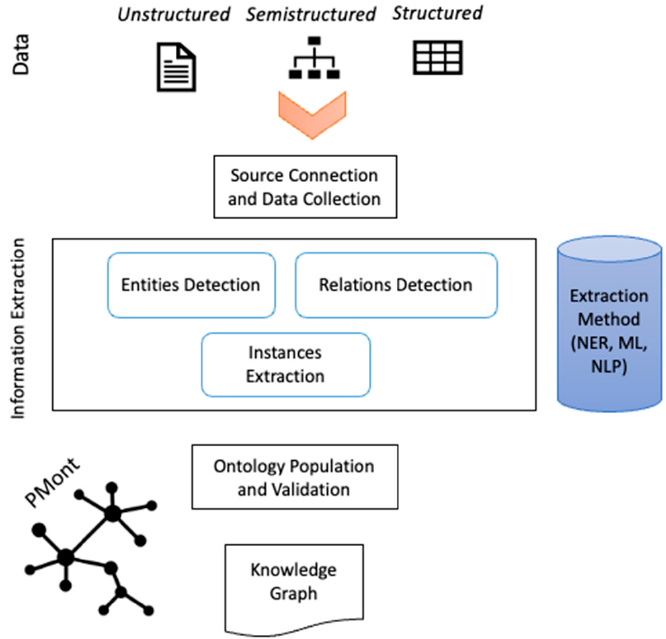
Figure 1. Integroly functional architecture.